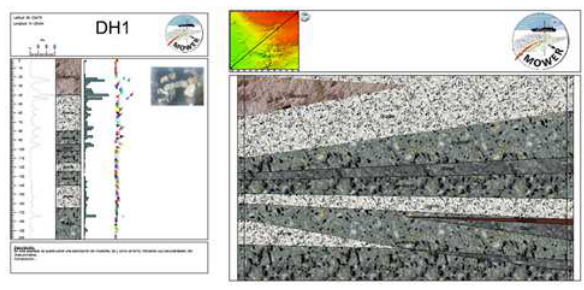
Figure 17. Stratigraphic documentation of a sample and cross section between two samples